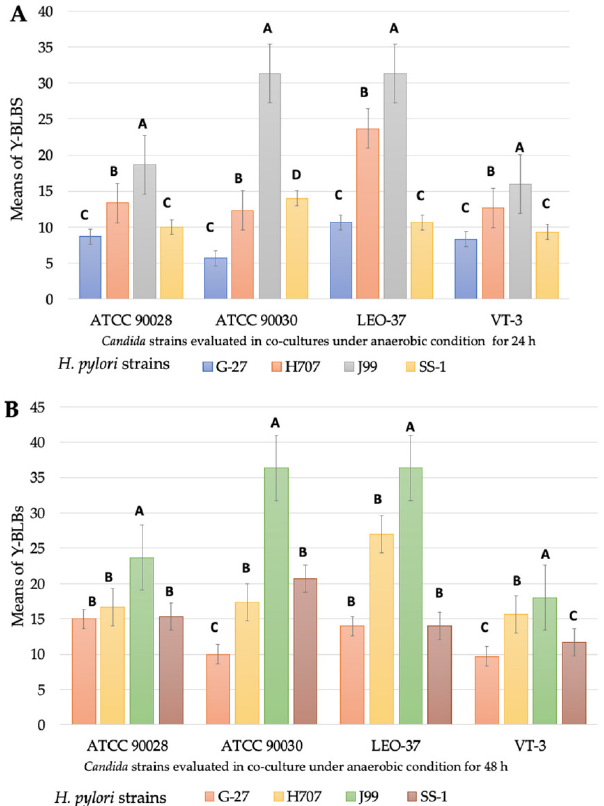
Figure 7. Means of intra-yeast bacteria-like bodies (Y-BLBs) found in H. pylori strains and Candida strains, co-cultured under anaerobic conditions for 24 h ( A ) or 48 h ( B ). At both incubation times, the higher means of Y-BLB percentages were found when the H. pylori J99 strain was co-cultured with C. glabrata strains. Different letters indicate significant differences ( p < 0.05). Strains ATCC 90028 and VT-3 belong to C. albicans species and strains ATCC 90030 and LEO-37 belong to C. glabrata species . 3.3. Identification, at the Species Level, of Intra ‐ Yeast Bacteria ‐ like Bodies (BLBs) The fluorescent in situ hybridization (FISH) technique revealed that yeast cells pre ‐ viously found to contain BLBs showed the expected red fluorescence corresponding to the Cy3 ‐ labeled fluorescent probe specific for H. pylori DNA. This assay allowed us to identify BLBs as cells belonging to the species H. pylori growing inside the Candida cells (Figure 8). Furthermore, the identification, at the species level, of Y ‐ BLBs as H. pylori was also sup ‐ ported by the amplification of the H. pylori gene codifying its 16S RNA in the total DNA extracted from yeast cells which were previously co ‐ incubated with H. pylori cells, and then the presence of Y ‐ BLBs was confirmed (Figure 9). Together, both assays confirmed that the BLBs observed under an optical microscope corresponded to intracellular H. py ‐ lori within Candida cells.